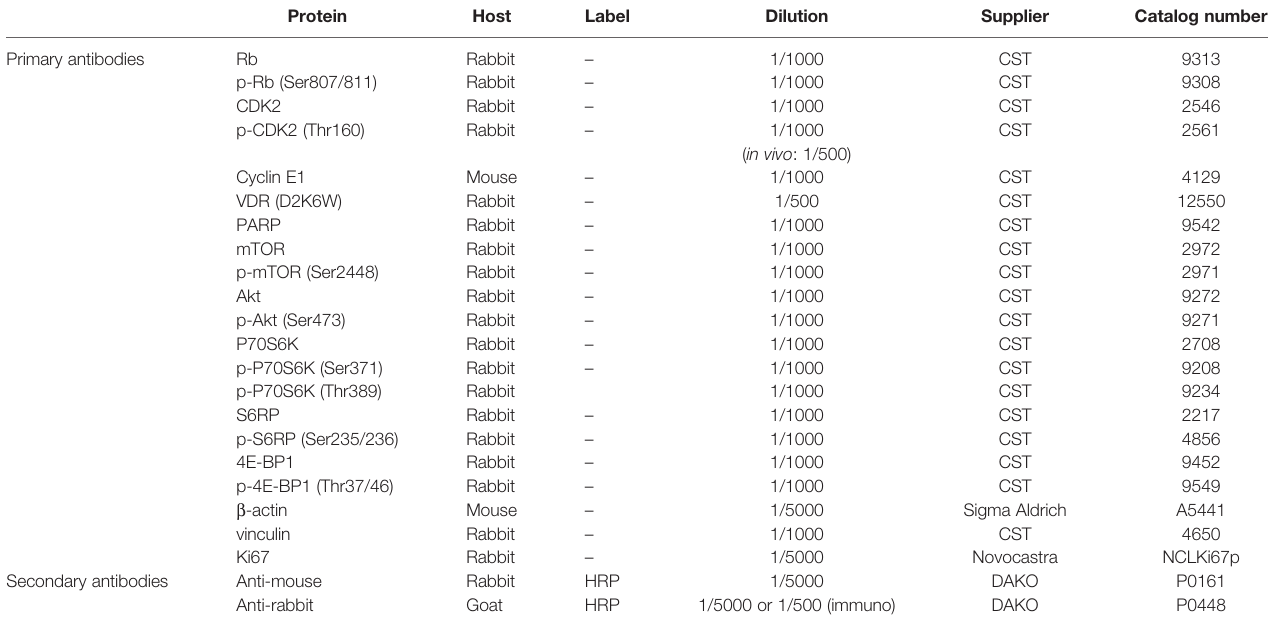
TABLE 2 | Overview of antibodies used for western blot and immuno fl